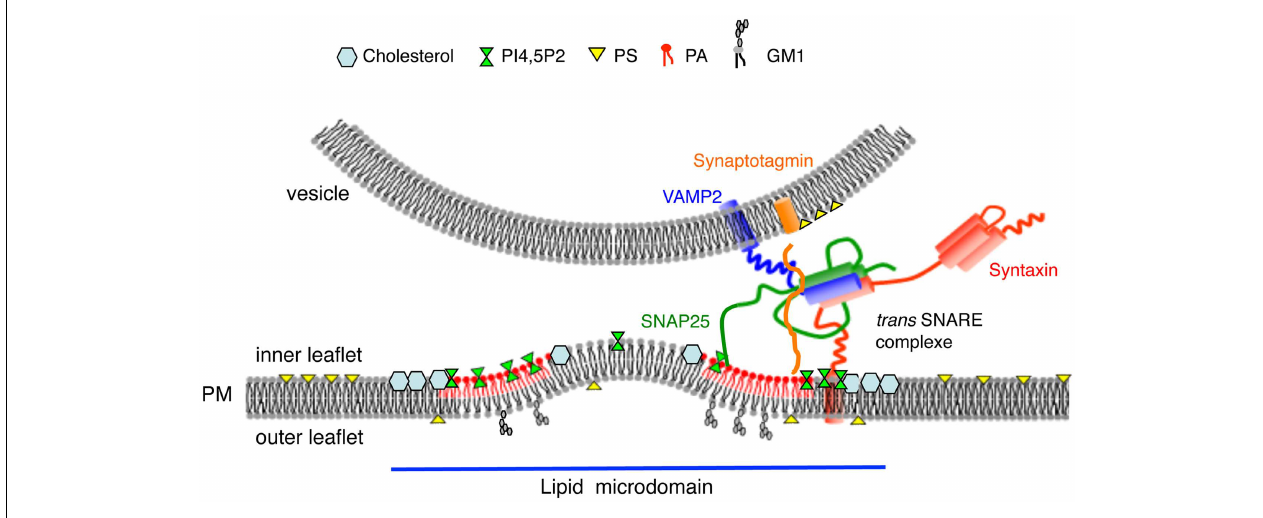
and create membrane curvature of the inner leaflet of the plasma membrane prior to promote membrane merging. PtdIns(4,5)P 2 and PA may also regulate SNARE complex assembly and